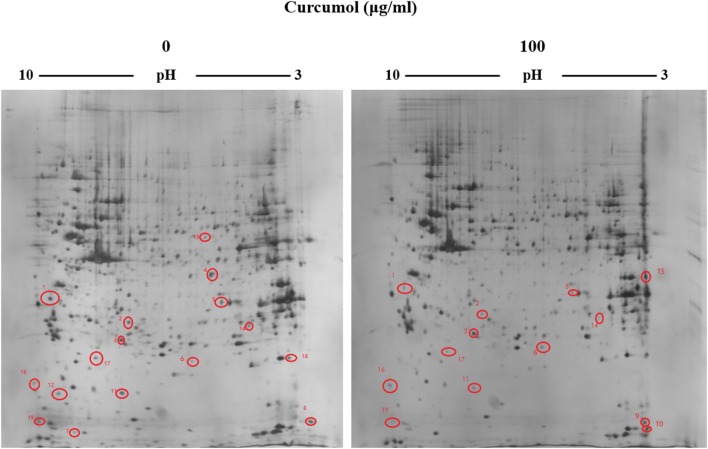
Representative 2-DE gels derived from the RBE cells exposed to curcumol or 1% DMSO. Cells were treated with 100 μg/ml of curcumol or 1% DMSO for 48 h. The differentially expressed protein spots were marked on the maps. The map was a representative of three independent runs.